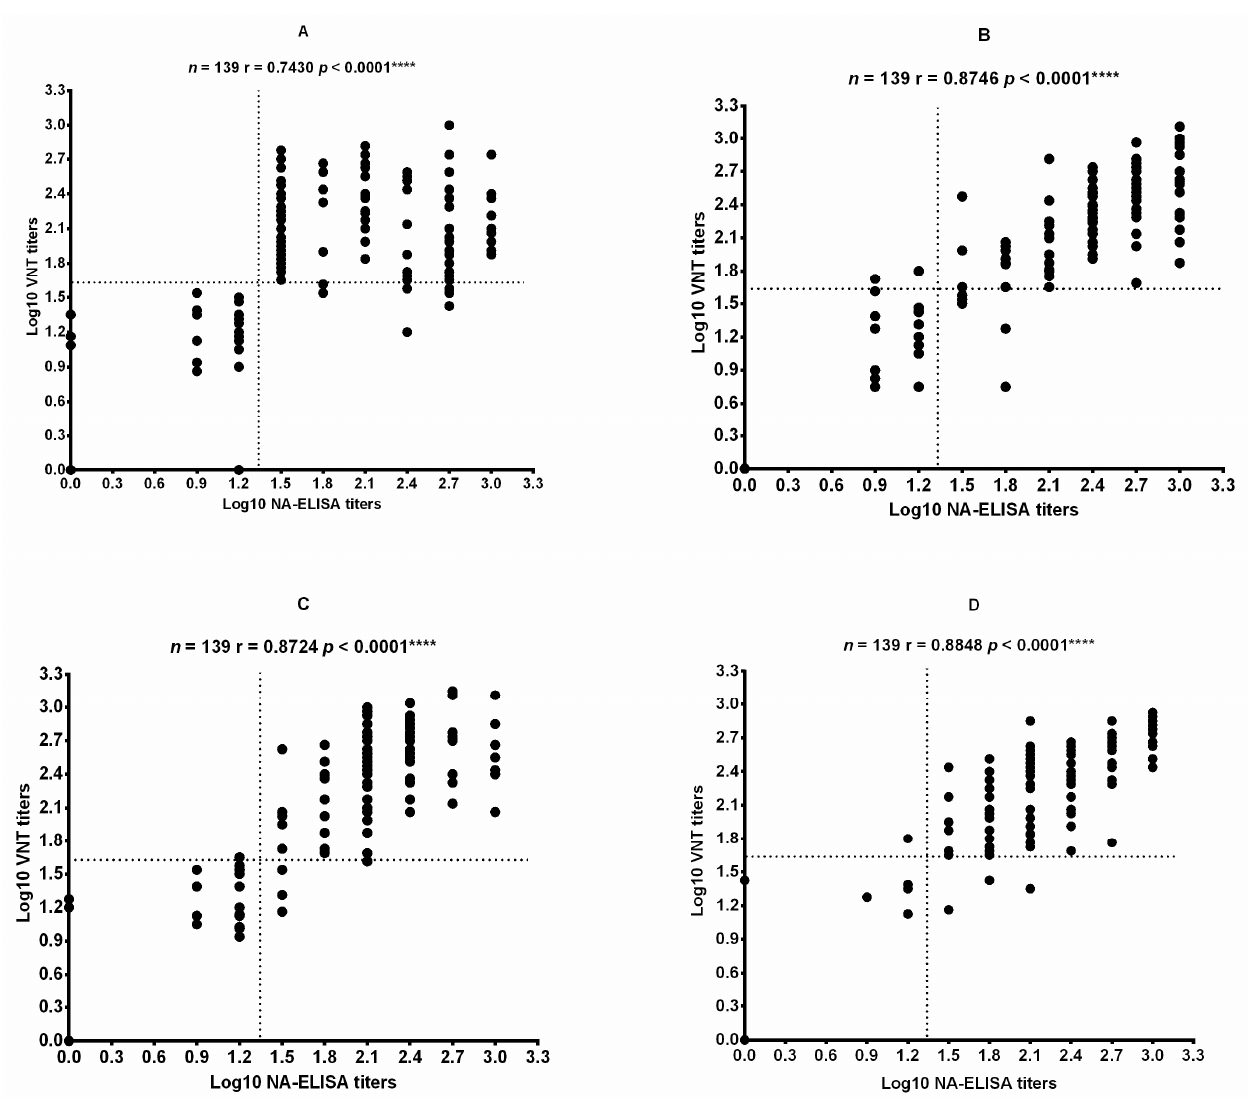
Figure 4. Correlation of the titers obtained by the NA-ELISA and VNT using different FMDV strains. ( A ) FMDV SCGH/CHA/2016. ( B ) FMDV O/Mya/98. ( C ) FMDV O/Tibet/99. ( D ) FMDV O/XJ/CHA/2017. Pearson’s correlation coefficient was computed using GraphPad Prism (version 6.0) software (San Diego, CA, USA). n , number of serum samples tested; r, correlation coefficient. The P value is two-tailed. The dotted lines represent the cutoff values. **** p < 0.0001.